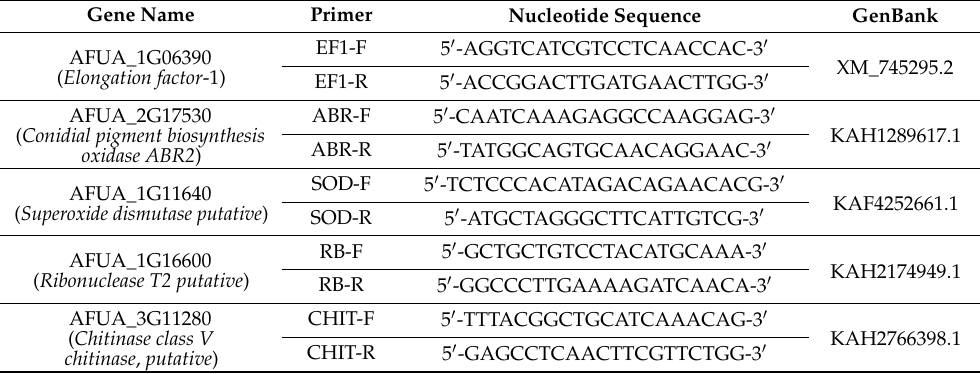
Table 1. Nucleotide sequence of A. fumigatus primers for